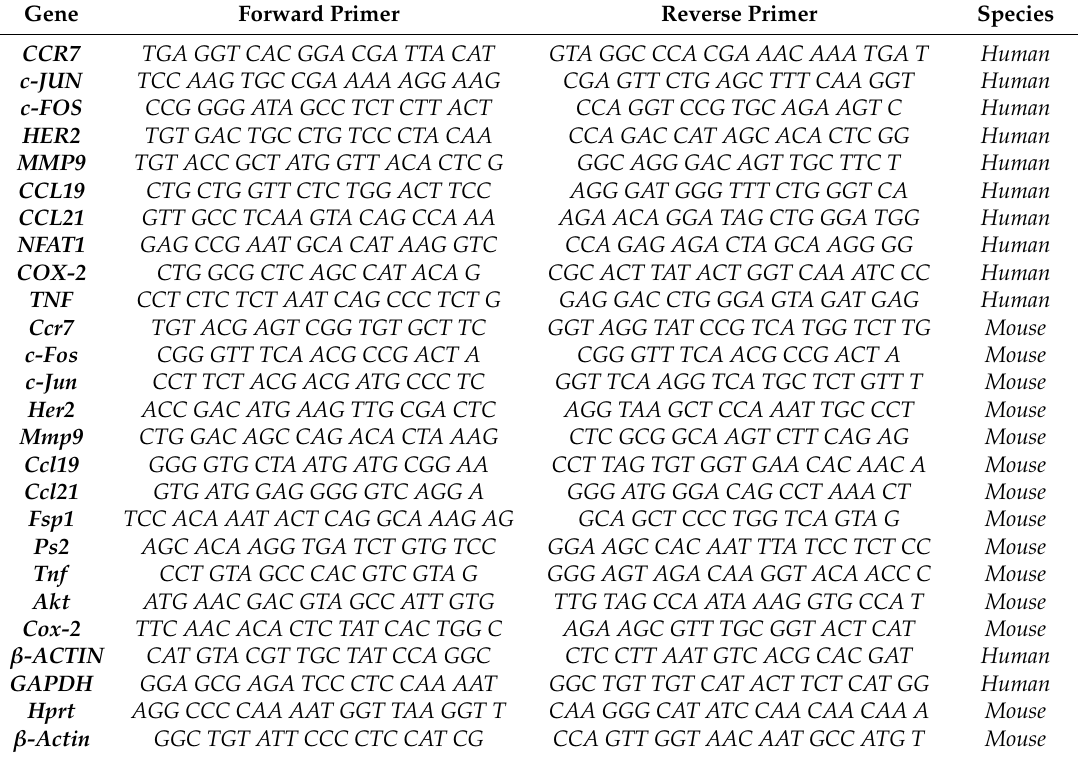
(Table 1). Gene expressions of β -ACTIN and GAPDH were used as the control gene for Mcf7 cells. Hprt gene expression was used as a control in tumor and for lung samples the β -actin gene was used as a housekeeping gene. All experiments were repeated at least three times. Fold change in gene expression was calculated based on the cycle threshold and amplification curves were used to monitor mRNA values. Table 1. Primers used for real-time or conventional